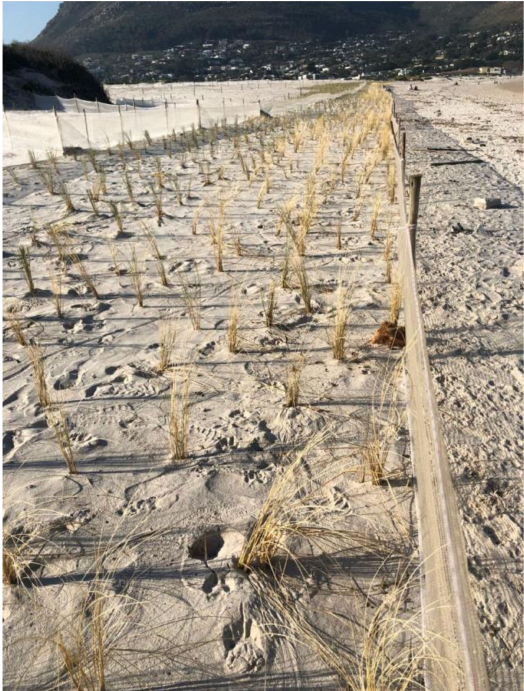
Figure 9. Marram grass planted at Hout Bay in 2017, near Cape Town to prevent sand from blowing onto the car park at the harbour (photo: Ted Avis). This project won the South African Landscapers In- stitute’s (SALI 2020) top award for excellence in landscaping, out of more than 100 projects